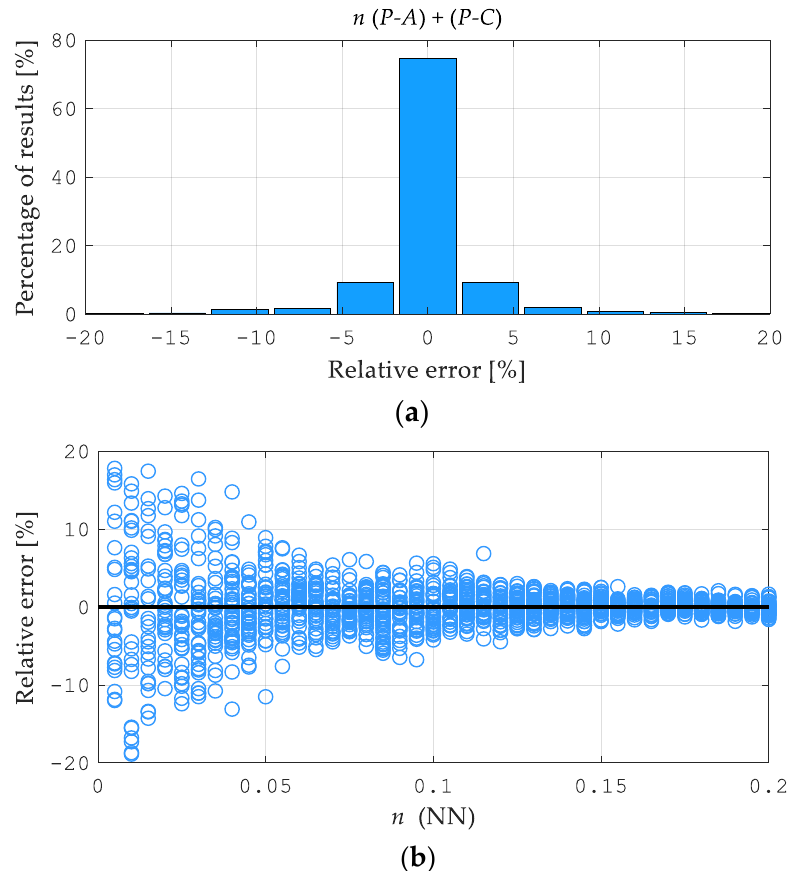
Figure 12. Errors of the P-A and P-C procedures in the estimates of the yield point σ Y : ( a ) histogram of the error distribution, ( b ) the error distribution of the parameter values.